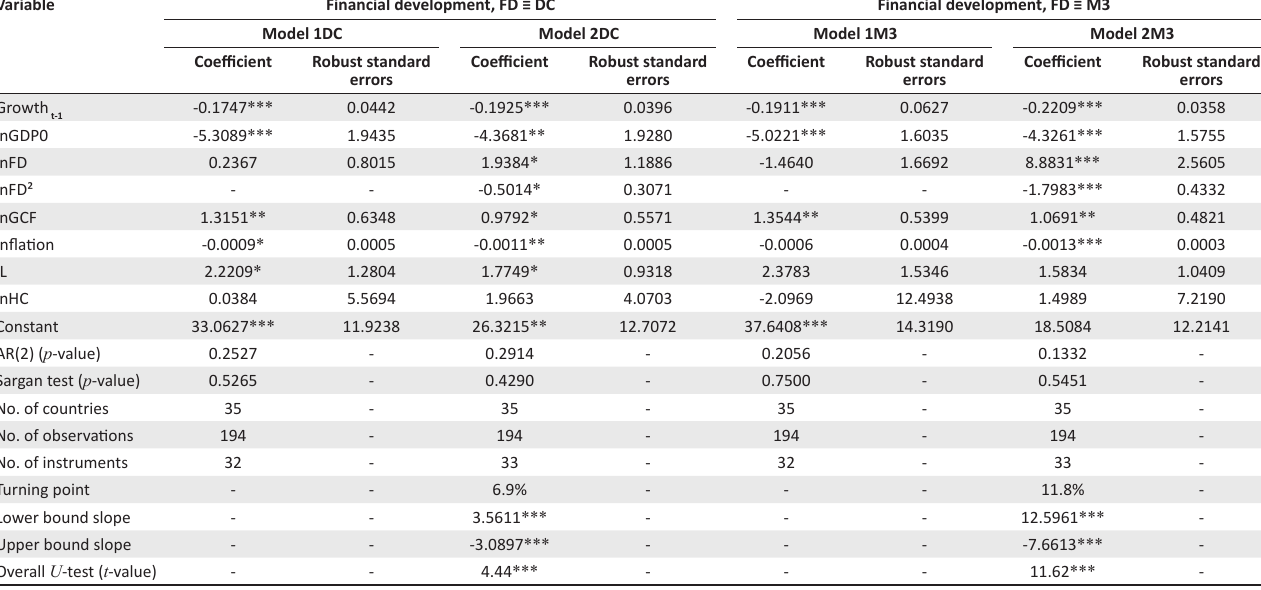
TABLE 3: Two-step system-generalised method of moments